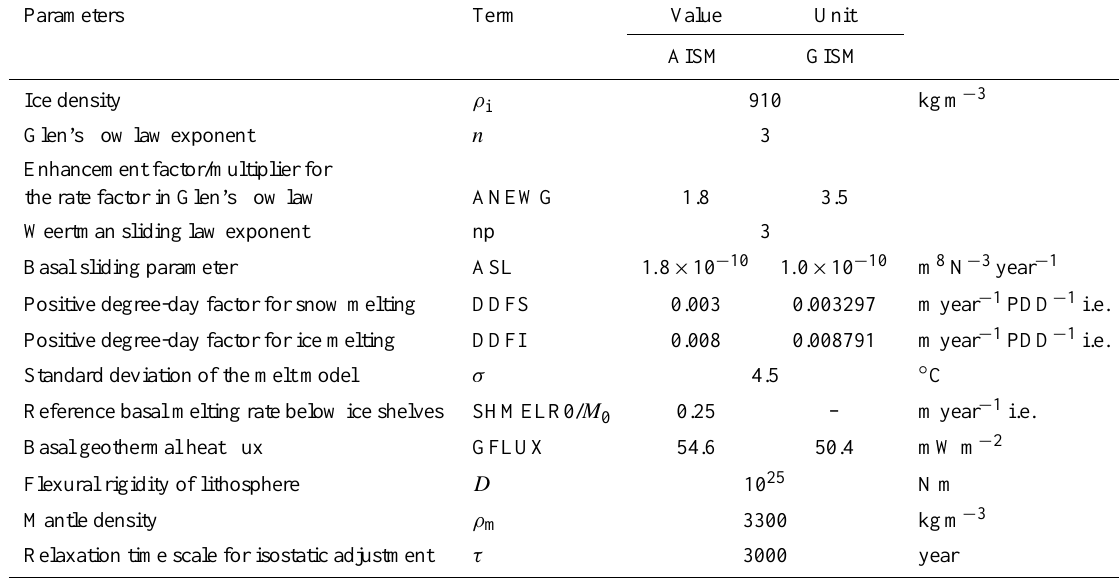
Table 5. Major parameters of